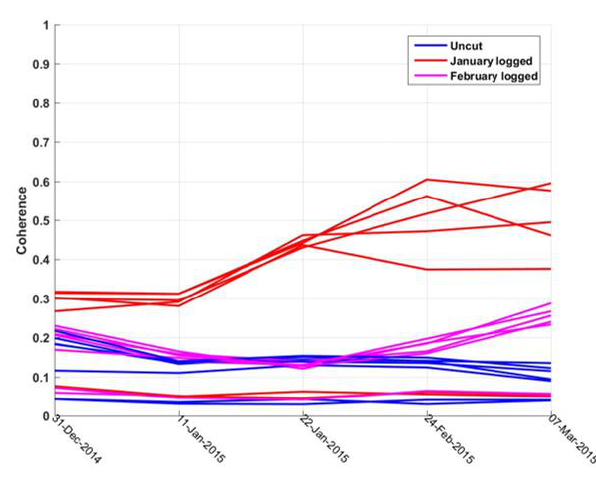
Figure 4 Pol-InSAR coherence trend for uncut (blue), January cut (red) and February cut